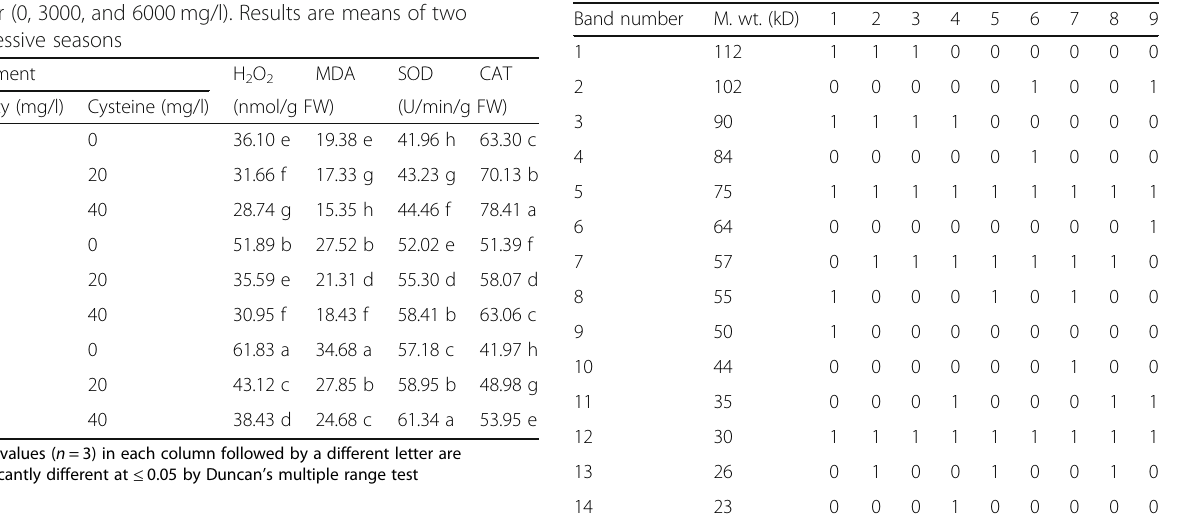
Table 5 Effect of salinity stress and/or cysteine treatments on protein pattern (SDS-PAGE) of water-soluble proteins of fresh soybean leaf tissues